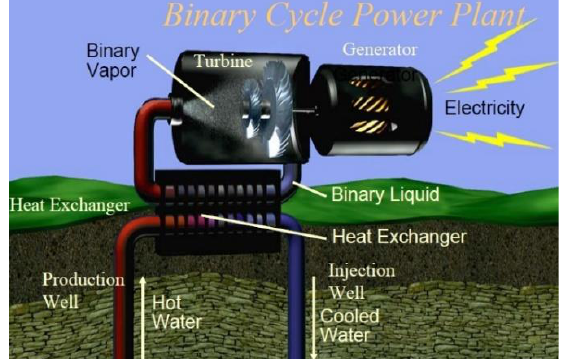
Figure 6. Binary cycle power plant for geothermal reservoirs [34].